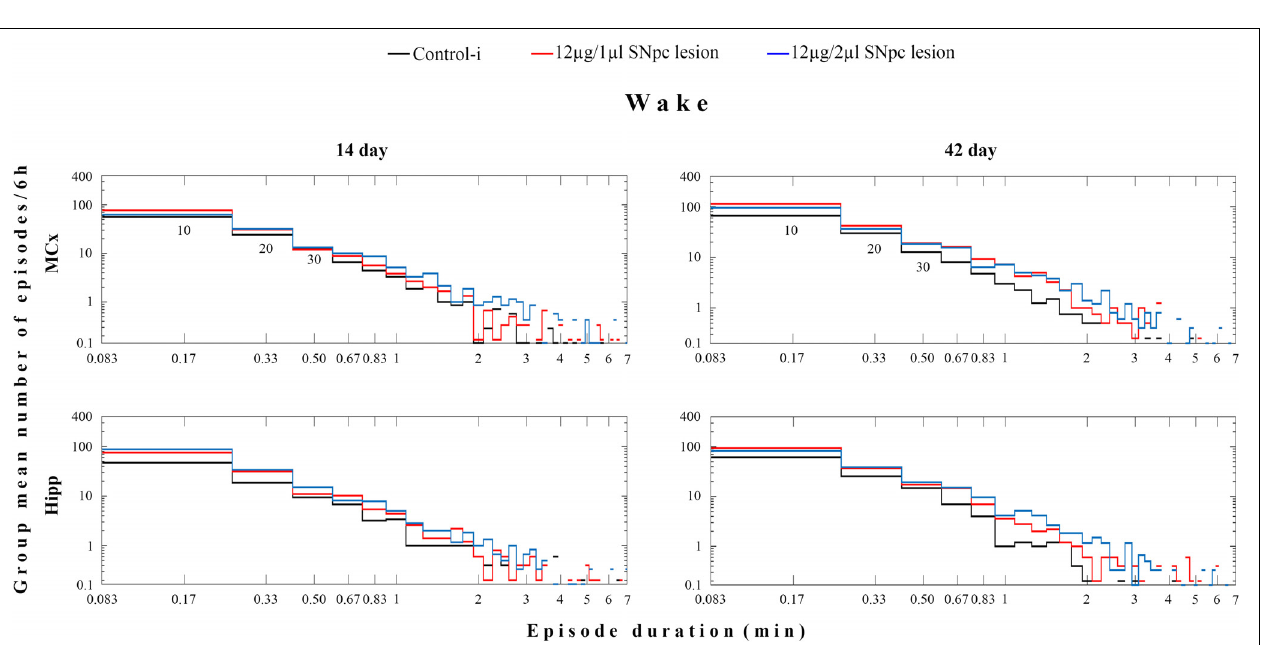
FIGURE 2 | Wake episode dynamics in the MCx and hippocampus (Hipp) at 14 and at 42 days following the SNpc lesion caused by a microinfusion of 12 µ g/1 µ l 6-OHDA and 12 µ g/2 µ l 6-OHDA in contrast to the implanted controls (Control-i) - the group distributions of the mean number/6 h of Wake episodes over